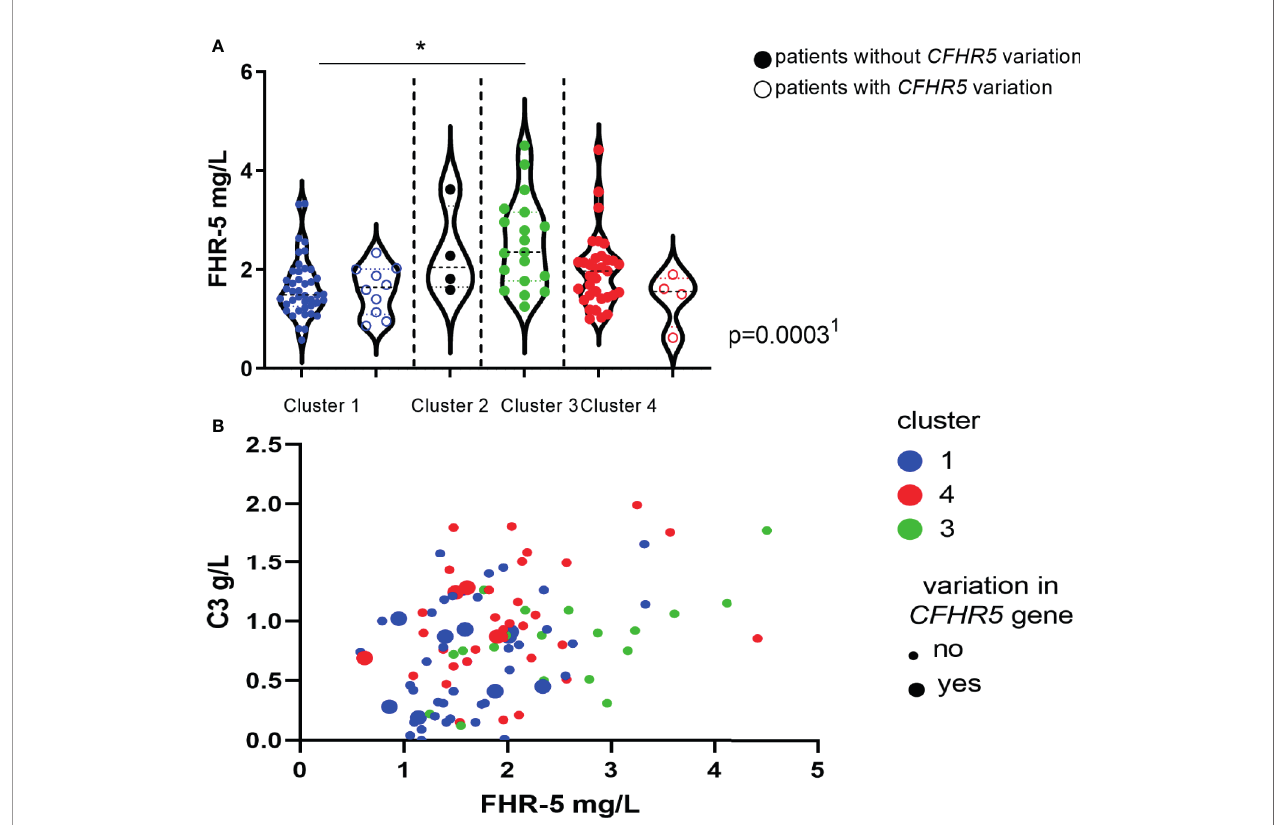
FIGURE 9 | (A) Factor H-related protein 5 (FHR-5) protein levels in the previously described clusters of C3 glomerulopathy (C3G)/immune complex-mediated membranoproliferative glomerulonephritis (IC-MPGN) patients (19, 37). The clinically meaningful clusters were generated based on clinical, histological, genetic, and complement data of patients as described by Iatropoulos et al. (19). Each dot represents one patient. 1 p-value was determined with ANOVA for patients without CFHR5 variations comparing patients in clusters 1, 3, and 4. *p < 0.05 by Dunn ’ s posttest, for patients without CFHR5 variations. (B) C3 and FHR-5 levels according to cluster membership and the presence of CFHR5